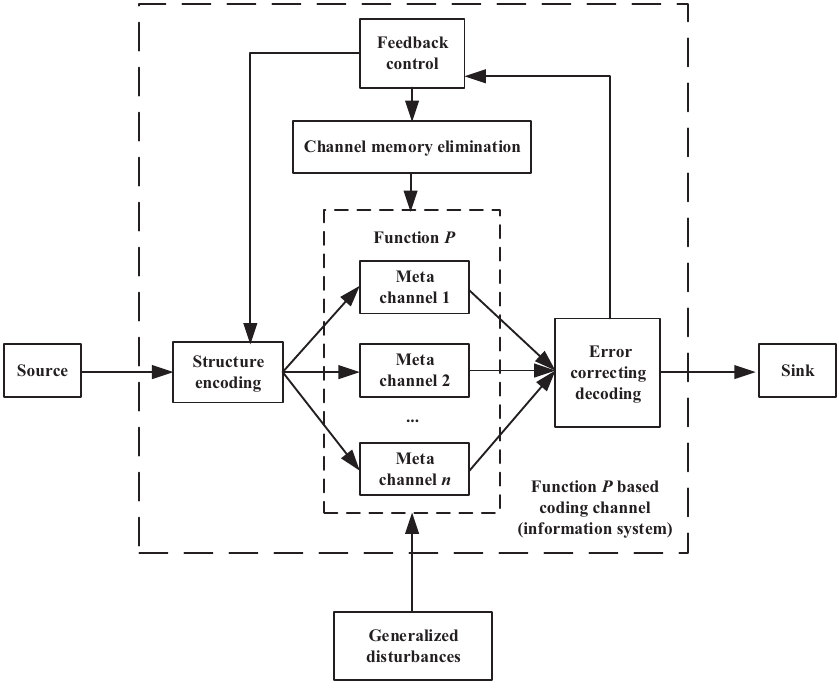
Figure 6. Model of DHR architecture